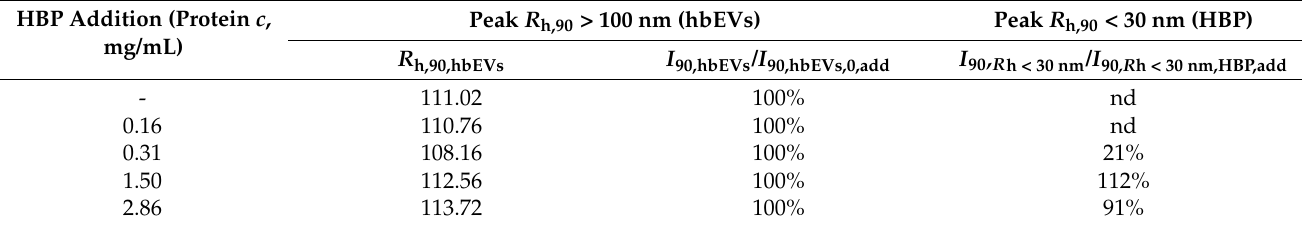
Table A1. Values of hydrodynamic radius R h and the intensities ascribed to the peak pertaining to hbEVs (mean R h > 100 nm) and of smaller particles (mean R h < 30 nm) in mixtures of hbEVs and blood plasma (HBP) from the same donor in PBS–citrate as determined by DLS. The addition of HBP is specified by the estimated protein concentration in the final sample. The intensities that were ascribed to a selected peak in the mixture are presented as the percentage of the values obtained for the same peak in the separate suspensions of hbEVs or in HBP at the same dilution as the one used in mixture.